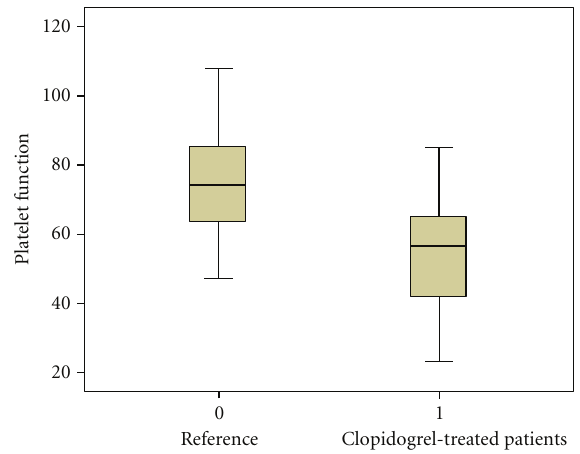
Figure 3: Boxplots showing the distribution of ADP values for patients with (right) and without DWI lesions (left) after the pro-